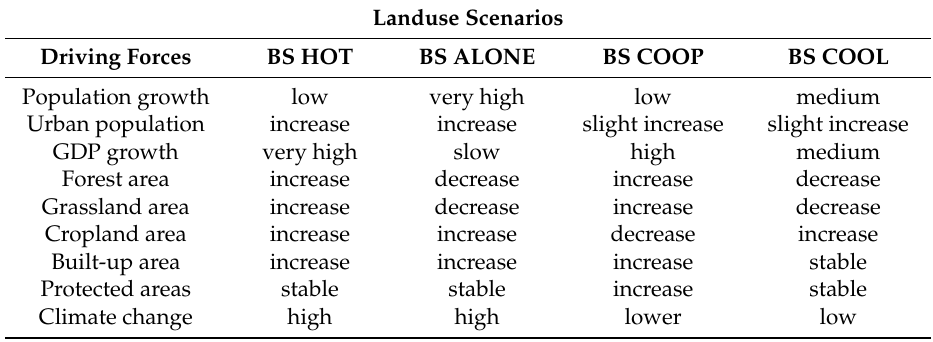
Table 1. Summary of landuse trends and driving forces in the Black Sea Catchment’s